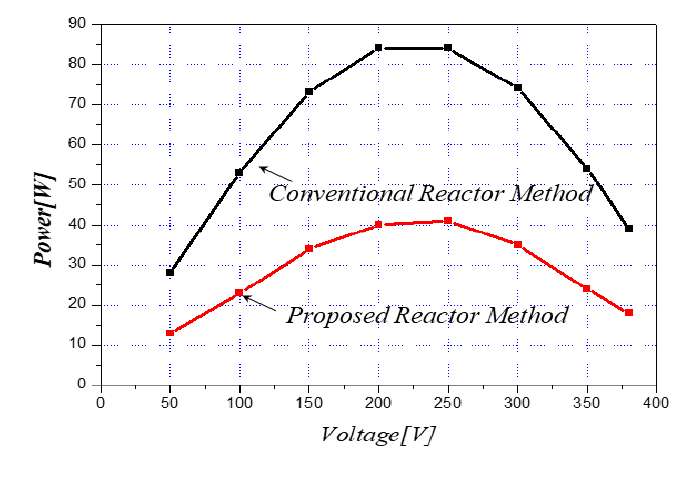
Figure 17. Comparison of input power at no-load.